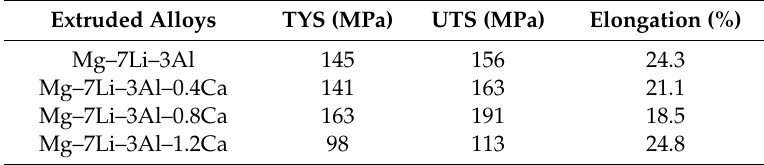
Table 5. Values obtained from the potentiodynamic polarization tests (in Figure 7).